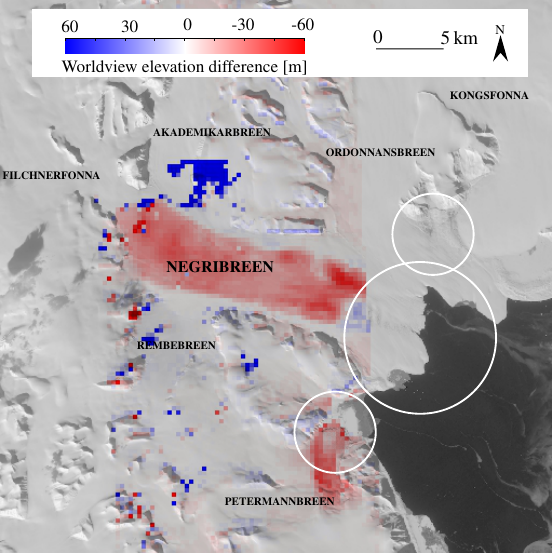
Figure 5. Elevation difference between Apr. 2014 - Aug. 2017, from ArcticDEM strip